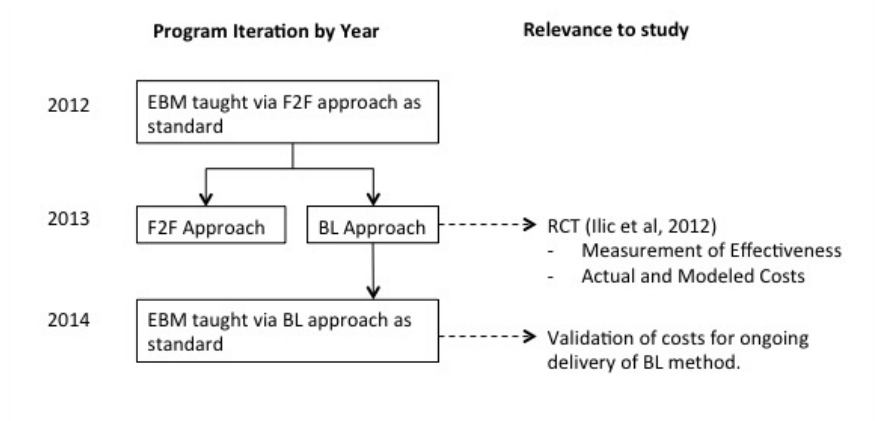
Figure 3. Program iterations and outputs relevant to past and current